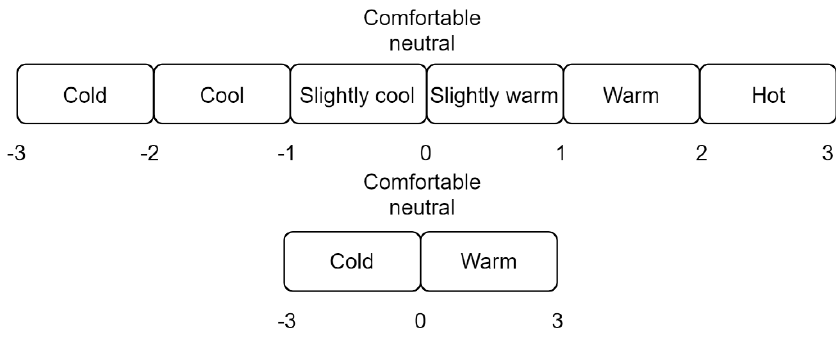
Figure 3. Seven- and three-value thermal comfort